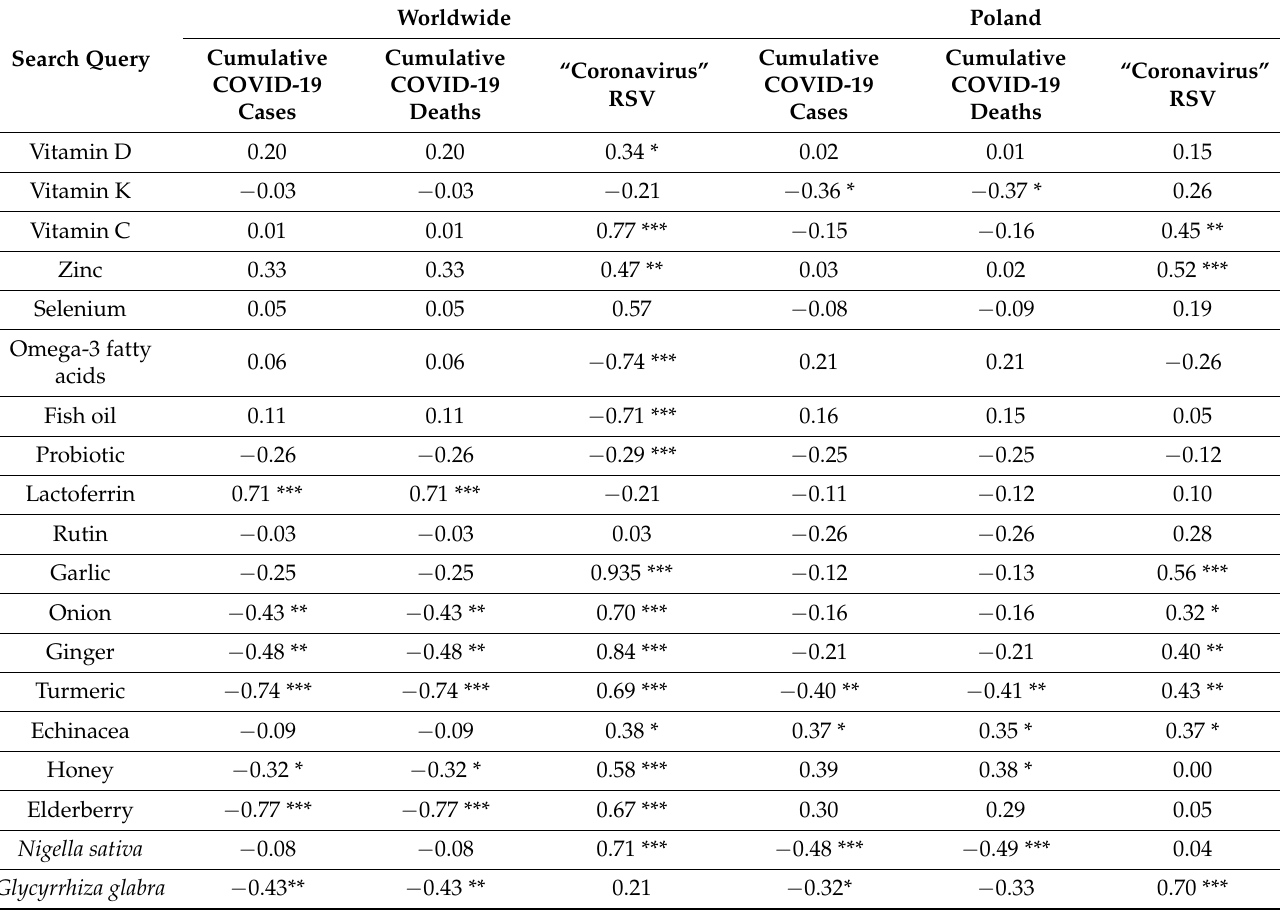
Table 1. Spearman rank’s coefficients between nutrients, bioactive compounds, and herbs RSVs and cumulative confirmed COVID-19 cases, deaths, and coronavirus RSV worldwide and in